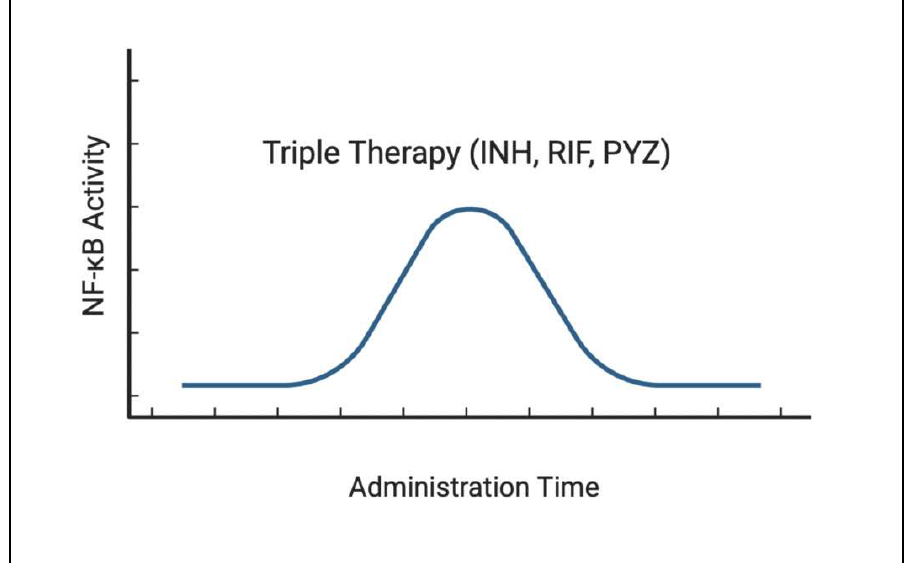
Figure 3. When treating tuberculosis infection with triple therapy, which includes isoniazid, rifampicin, and pyrazinamide, the level of NF-κB initially rises, which could assist with the clearance of the infection. However as the administration time continues with triple therapy, the level of NF-κB subsequently begins to decline after some time.